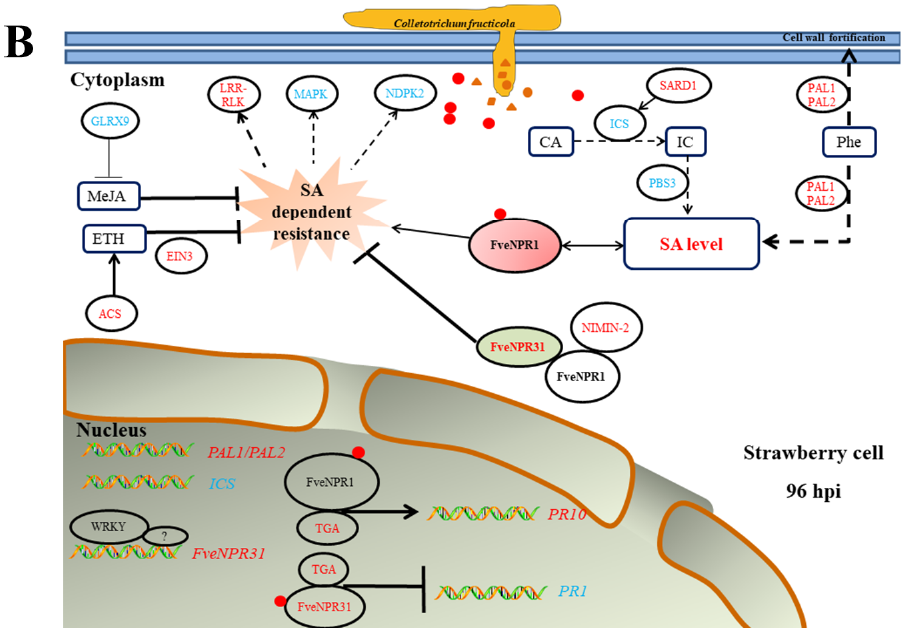
Figure 10. A hypothetical model depicting the transcriptional events related to NPR1- and NPR31- mediated defenses in susceptible strawberry upon invasion with a hemibiotrophic fungal pathogen Colletotrichum fructicola . ( A ) At 6 hpi early stage, the strawberry cell accumulates a relatively low or basal level of SA (red cycles). There is no monomeric NPR1 protein (ellipse), and it exists in cytoplasm as a large oligomer or forming heterodimer with the negative regulator NPR31. In the nucleus, the transcription of NPR1 is suppressed, while NPR31 transcription has been restored to a steady state after a transient induction. Simultaneously, the expression of pathogenesis-related gene PR1, as well as SA synthesis genes ICS and PAL , show a similar dynamic pattern to that of NPR31 . All events indicate a fast quenching of SA-dependent resistance, resulting in effector (small brown shapes)-triggered susceptibility (ETS). ( B ) At the 96 hpi late necrotrophic stage, the strawberry cell contains elevated SA due to the increased expression of PAL1/2. SA-dependent resistance is partially activated after NPR1 binds SA. Enhanced NPR31 negatively regulates SA-related immunity.